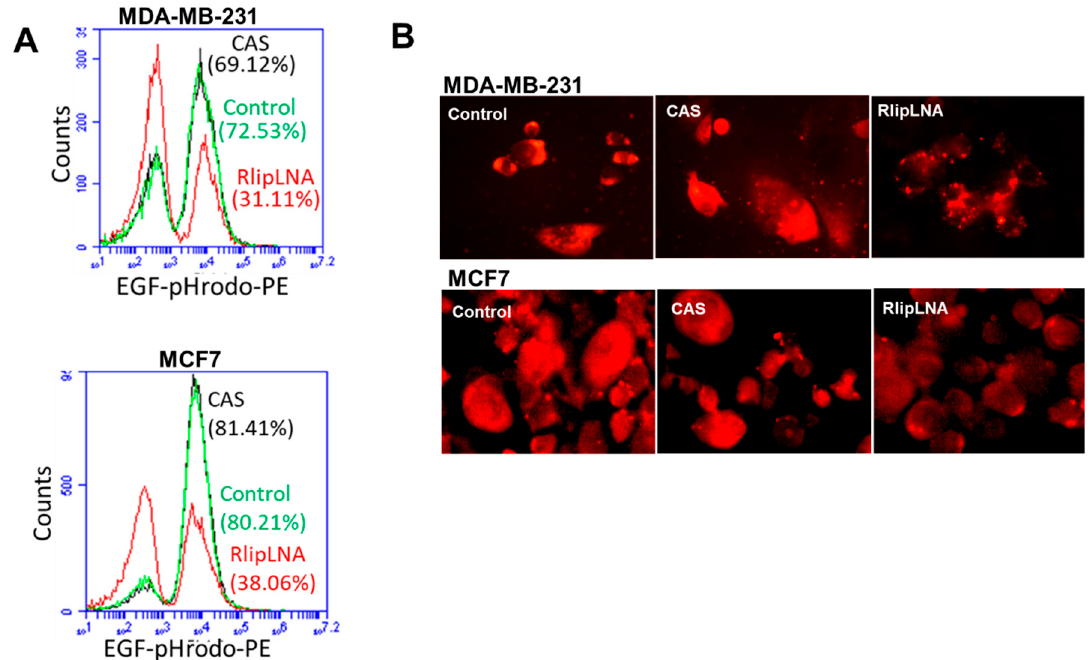
Figure 5. Effect of Rlip depletion on EGF binding and internalization. Cells were transfected with Rlip-LNA or control antisense (CAS), as described in the Materials and Methods. ( A ) Logarithmic histograms expressed as the fluorescence intensity of number of counts of the EGF-pHrodo-positive cells obtained from the statistical analysis of the fluorescence height and mean value of the x-axis displayed by the software. Data were obtained from three independent experiments. The fluorescence level for discrimination between EGF-pHrodo-positive and -negative cells was set using the unstained control. Viable cells were identified by gating on forward and side scatters. At least 10,000 cells were analyzed per staining. ( B ) Representative microscopic images of EGF-pHrodo staining for EGF internalization from three separate experiments for Rlip-LNA transfected, CAS, and vehicle control.